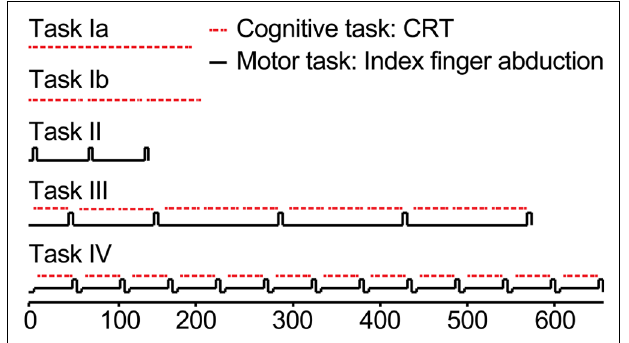
FIGURE 1 | Schematic overview of the protocol. Red lines represent the cognitive task, black lines the motor task.Task Ia, practice of the choice reaction time task (CRT), 150 consecutive stimuli.Task Ib, practice of the choice reaction time task (CRT), 3 times 50 stimuli.Task II, right index finger abduction, determination of maximal voluntary force (MVC).Task III, Single CRT-task. Responding to the auditory stimuli as fast and as accurate as possible.Task IV, Dual task. One session the dual-task at 30% of cMVC (30%-dual-task), one session the dual-task at 10% of cMVC (10%-dual-task). All subjects performed three sessions. In session 1, all tasks were practiced; session 2 and 3 were the experimental sessions in whichTask I to III were similar for the two sessions andTask IV was alternated between the 10 or the 30%-dual-task.